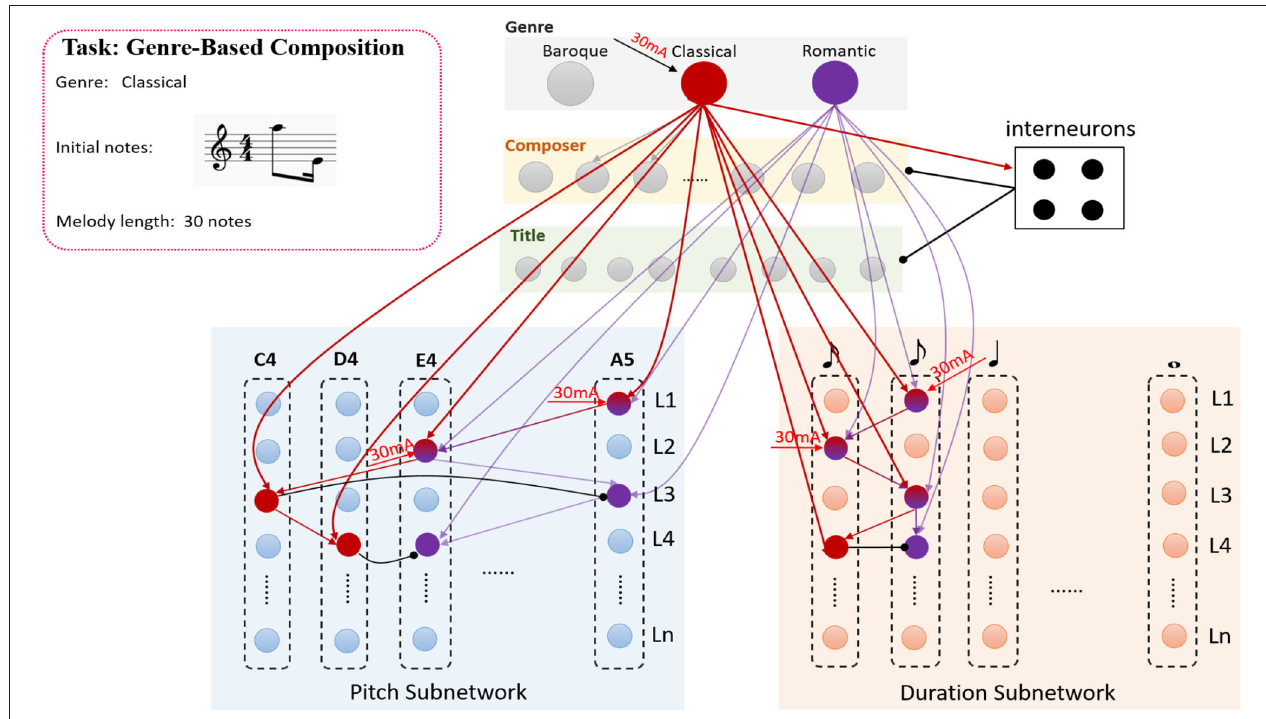
FIGURE 7 | The process of the genre-based composition, the example in this graph is to create a melody with a classical genre, the genre cluster-interneurons-memory system circuits are active in this